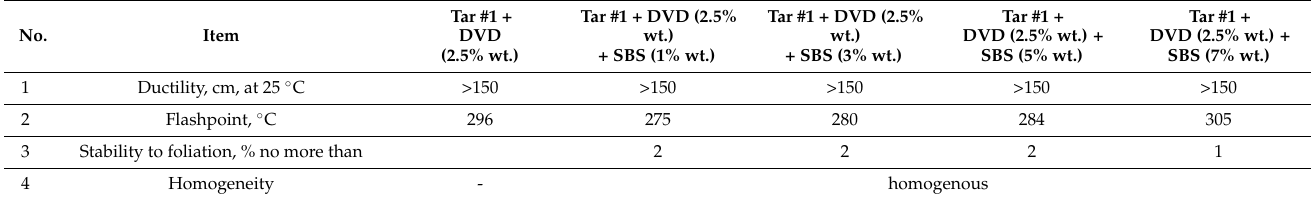
Figure 2. Dependence of brittleness temperature on Fraass on SBS concentration. Table 3. The test results of the modified bitumen at different concentrations of the